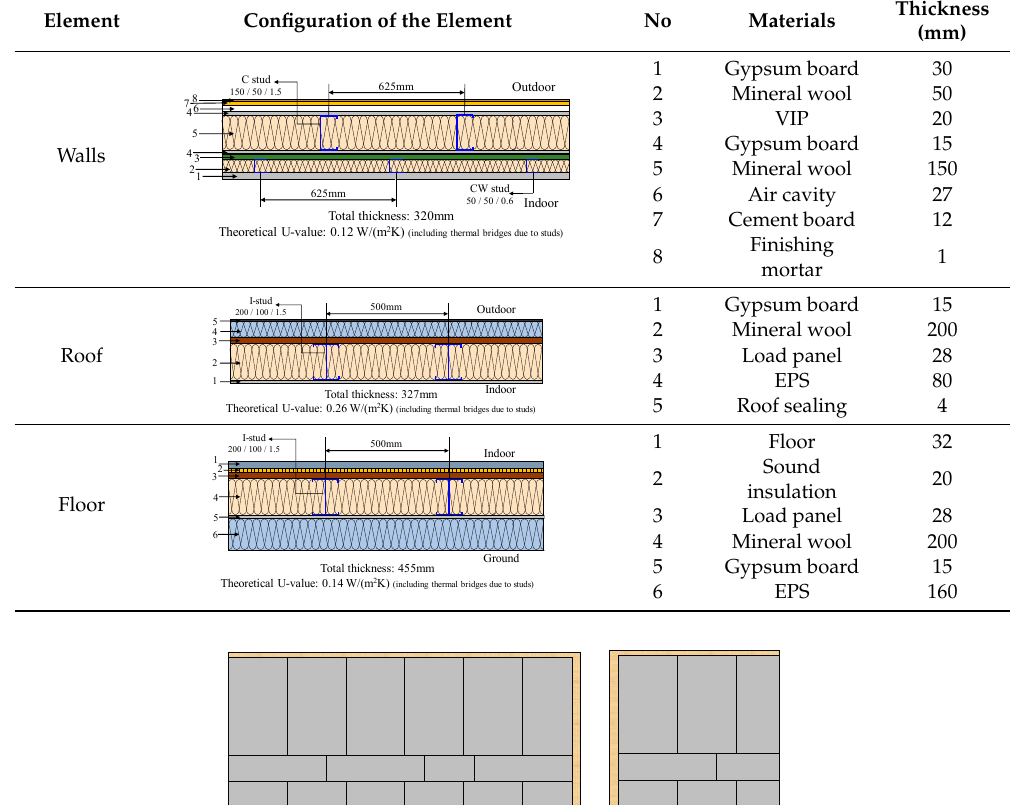
Figure 2. Pattern of the vacuum insulation panels (VIP) for ( a ) the north, ( b ) the east and west, and ( c ) the south wall. Table 1. The configuration of the elements of the building envelope. Element Configuration of the element